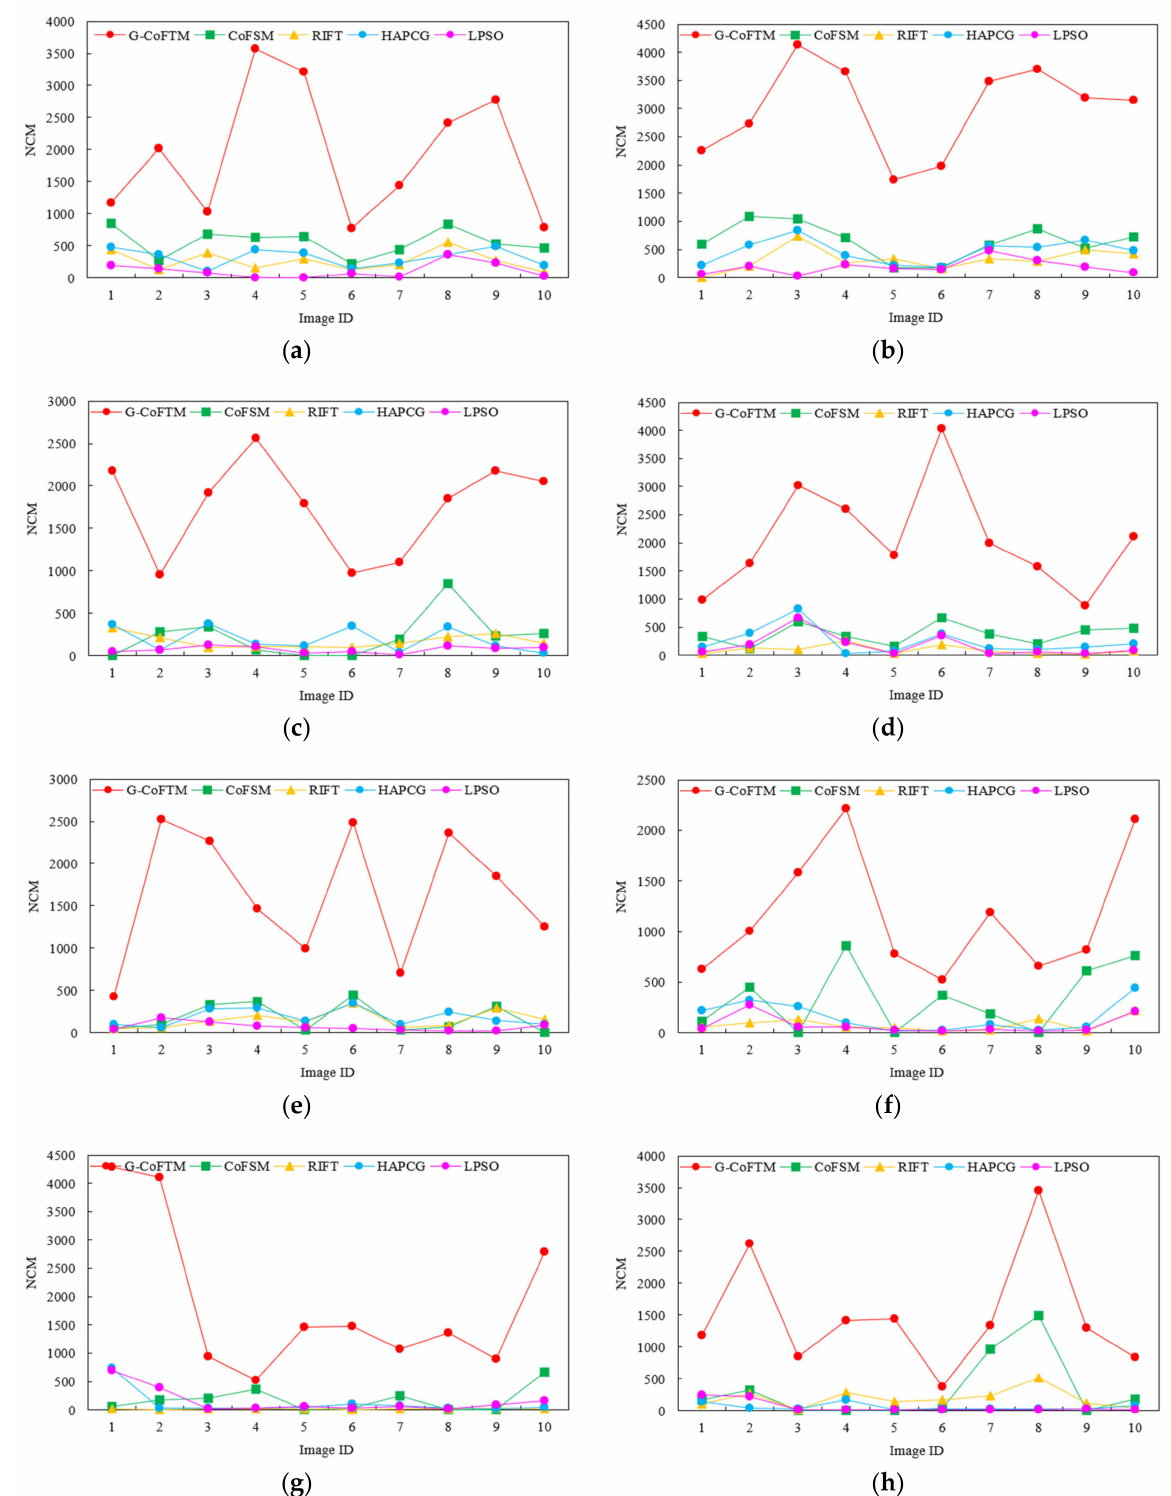
Figure 10. Comparisons on the NCM metrics: ( a ) Optical–Optical; ( b ) Optical–Infrared; ( c ) Optical– Depth; ( d ) Optical–Map; ( e ) Optical–SAR; ( f ) Day–Night; ( g ) Scale; ( h )